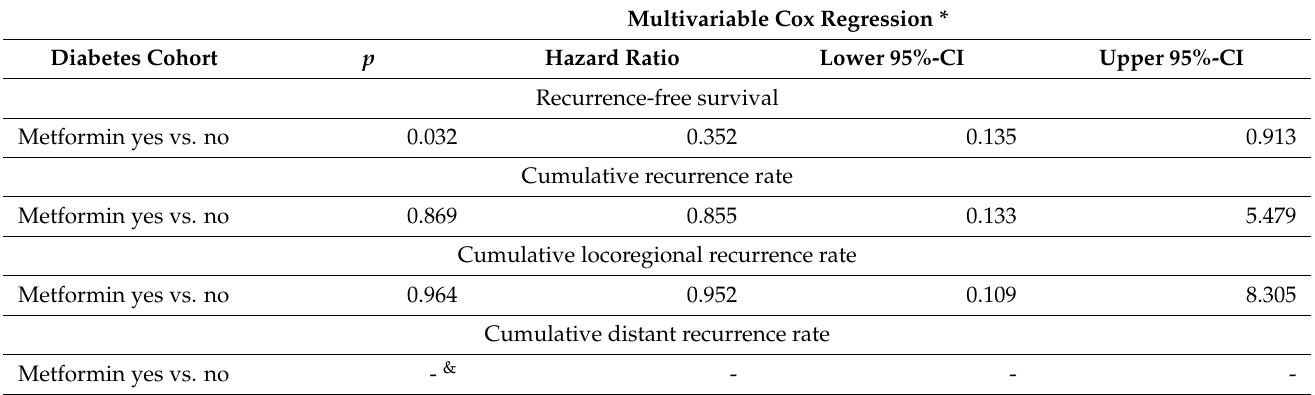
Table 4. Synopsis of the results from the multivariable Cox regression for RFS and cumulative recurrence rates according to metformin use in the diabetes complete